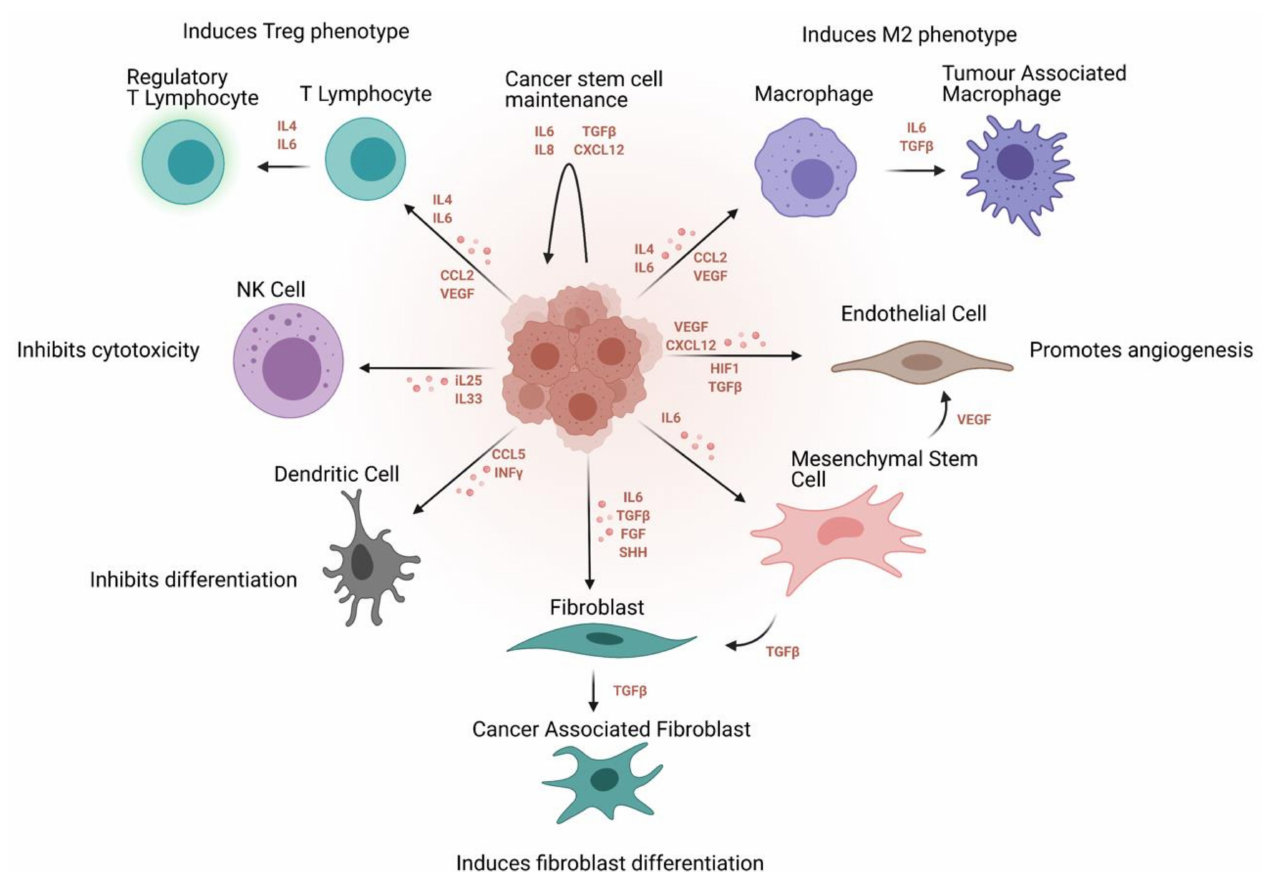
Figure 4. Immunosuppressive effect of the cancer stem cell niche on the tumour immune and non-immune microenviron- ment. Signaling molecules regulating these processes and the overall effect of the stem cell niche are